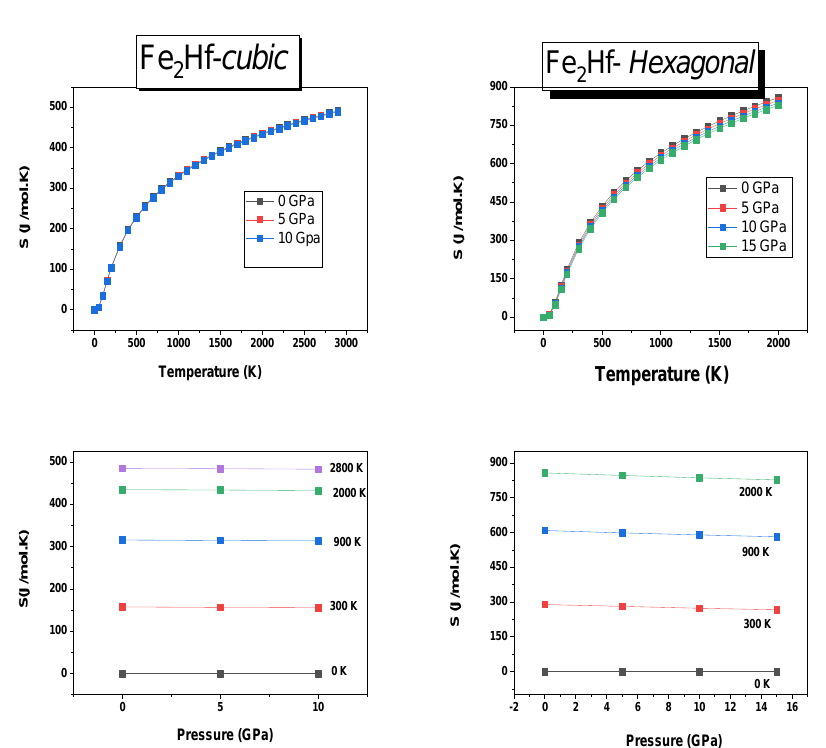
Fig. 12. Variation of entropy S with temperature T and pressures for c- Fe 2 Hf and h- Fe 2 Hf (upper panel),